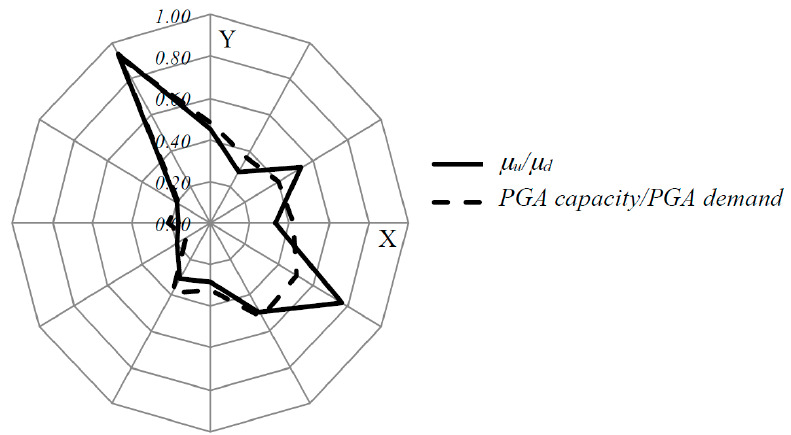
Figure 23. Comparison between the two proposed seismic vulnerability procedures all the investigated directions: ratio between capacity and demand in terms of ductility and peak ground acceleration (PGA).